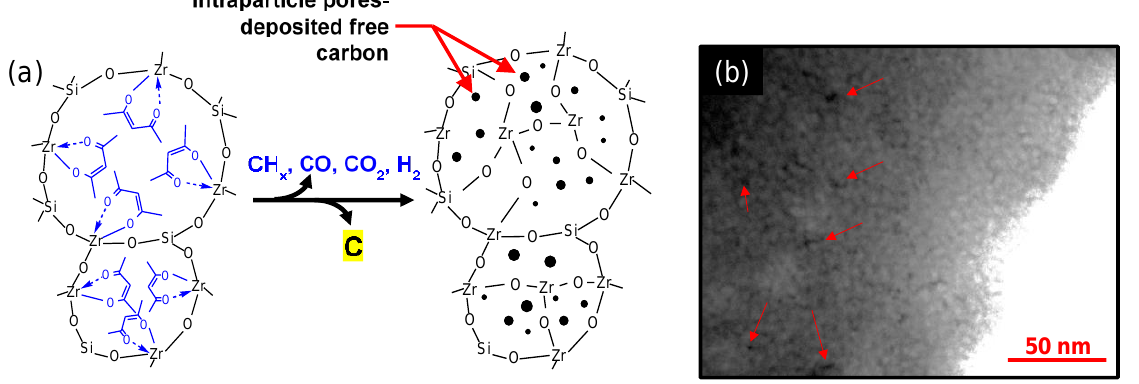
Figure 18. ( a ) Illustration of expected pyrolysis and network formation pathway of SiO 2 -ZrO 2 -AcAc to C-SiO 2 -ZrO 2 ; ( b ) TEM image of 550 °C-derived C-SiO 2 -ZrO 2 . Adapted from [105].